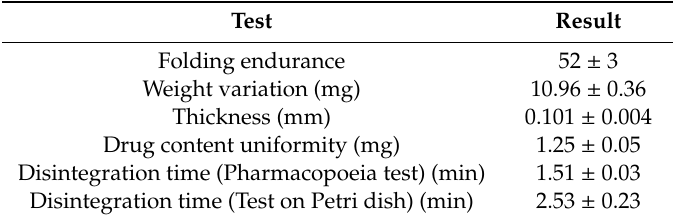
Table 4. Mechanical and physicochemical parameters for the drug-loaded films.